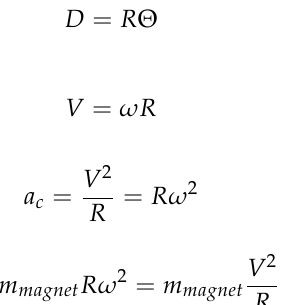
Figure 7. Sample velocity ( ˙ x ) and acceleration ( ¨ x ) of the magnet portion of the crank-slider harvester with ω of 2 π , r = 2.5 mm, and l = 222 mm, using Formulas (8) and (10), respectively [35]. An evaluation of magnet’s movement when rotating at the circumference of the edge of the fan blade, as shown in Figures 4 and 8, was performed using the following well- known formulas. The arc distance traveled ( D ) by the magnet from the initial position is given in Formula (11). The speed ( V ) of the magnet in Figure 8, given a uniform circular motion, is represented in Formula (12). The centripetal acceleration ( a c ) and force ( F c ) on the magnet due to a c are given in Formulas (13) and (14), respectively.